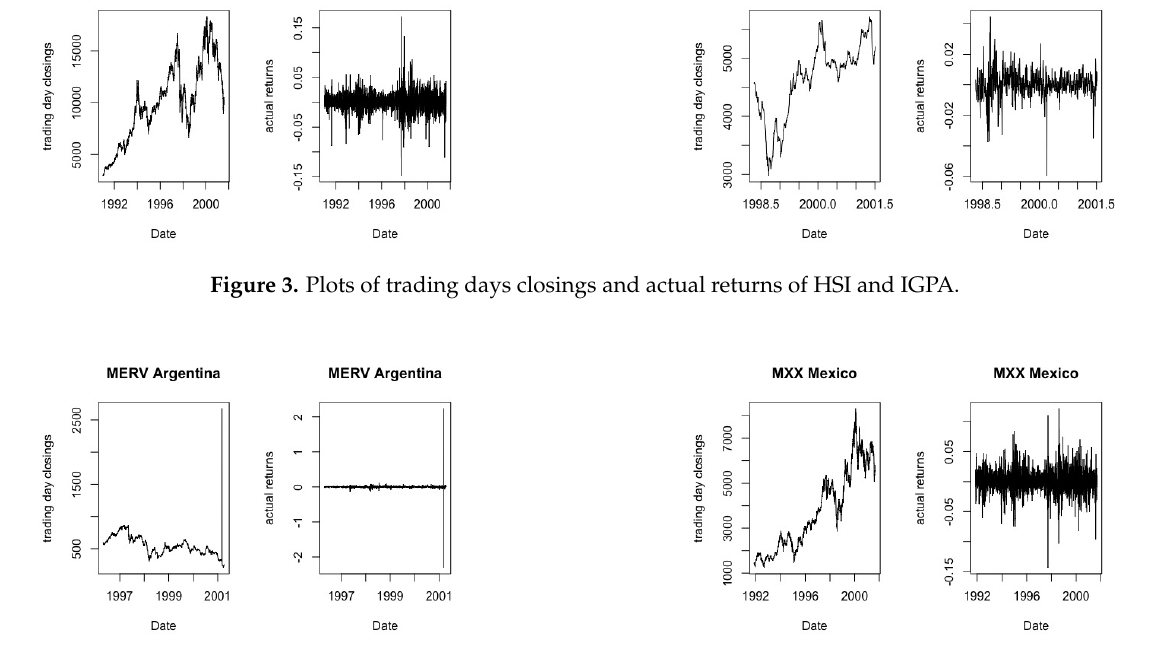
Figure 4. Plots of trading days closings and actual returns of MERV and MXX.